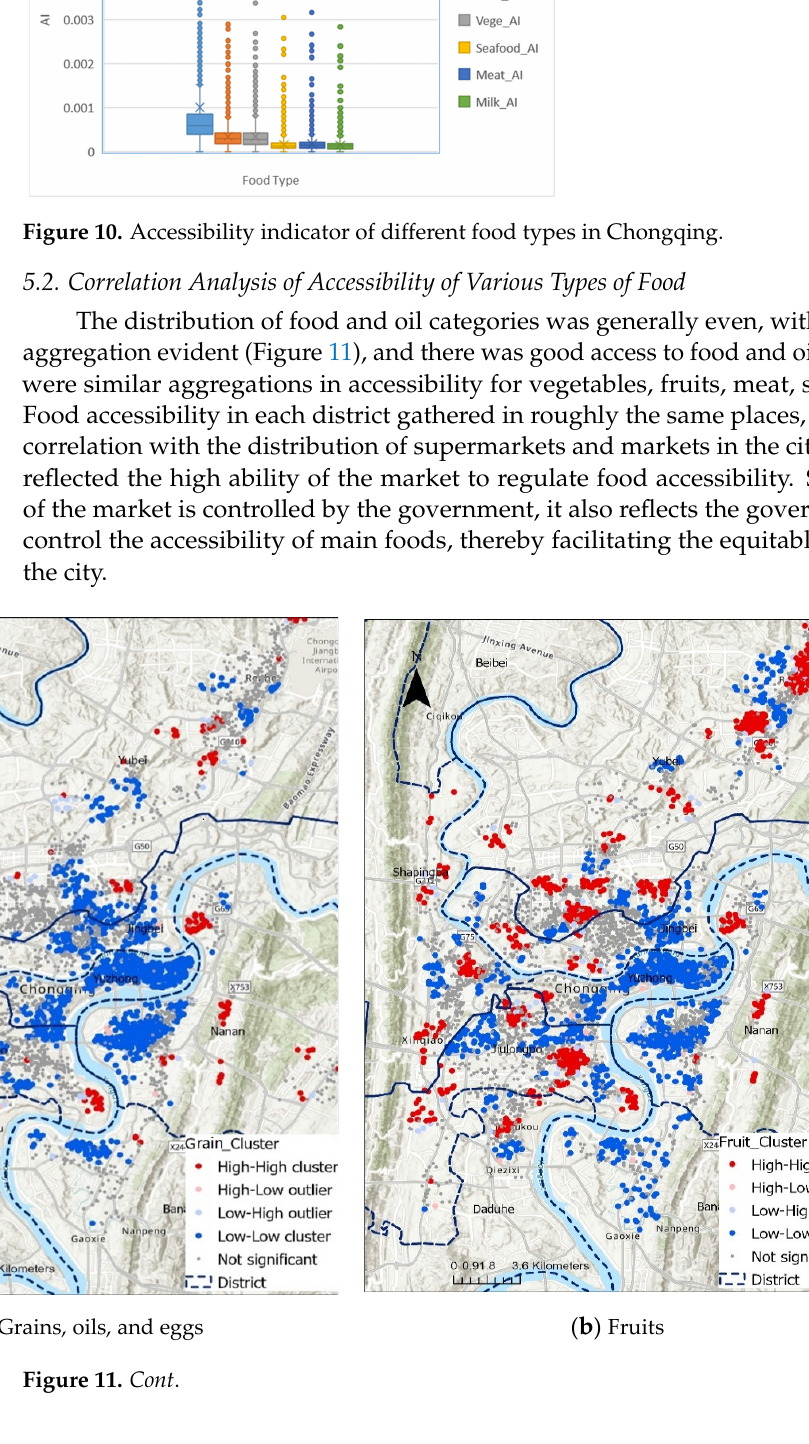
Figure 9. Spatial distribution of food accessibility in Chongqing.